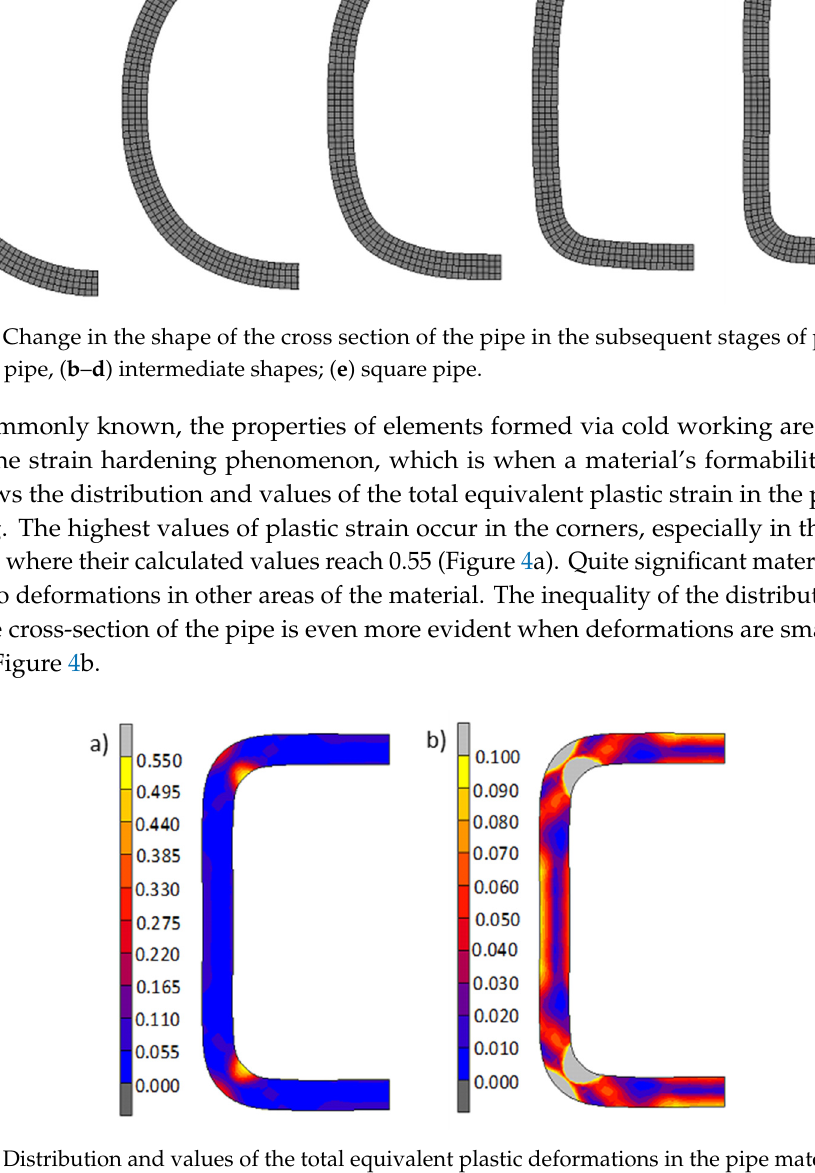
Figure 5. Distribution and values of the Huber–Mises equivalent stresses in the material of the shaped pipe: ( a ) in the final shaping phase and ( b ) after the shaping process (internal stress). Figure 3e shows the FEM analysis of the 25 × 25 × 2 beam bending process, which was carried out in two variants. In the first variant (Model A), both residual stresses and plastic deformation that prevail in the beam material after the technological process were taken into account (Figures 4 and 5b), whereas in the second variant (Model B), only the previously calculated cross-sectional shape was taken into account without considering residual stresses and deformations. Other parameters of the spatial stress state used in both models were the same. 3D models of the beam bending were made on the basis of bending device geometry, which was used in the experimental research described later in the article. Due to the occurrence of two plane symmetries while bending the tested beam along the beam axis and perpendicular to the cross-section in the middle of the distance between the supports, the numerical models were simplified to ¼ of the experimental model. The beam was defined as a deformable body, while the elements of the device in contact with it were perfectly rigid. To discretize the deformable body, 8-node hex-shaped elements of type 7 were used [21]. The size of the elements on the cross-section of the beam was 0.5 × 0.5 mm, while on its length it was 1 mm, which gave a total of 68,400 finite elements. The 3D model during bending, together with the mesh and defined bodies in contact, as well as planes of symmetry, is shown in Figure 6. An elastic–plastic model for beam material with a non-linear strain hardening curve described by the Hollomon power equation was adopted. The material parameters were the same and defined in the same way as during the simulation of the square pipe shaping process. In all models, the evolution of the plastic surface came as a result of the strain hardening phenomenon, which was described